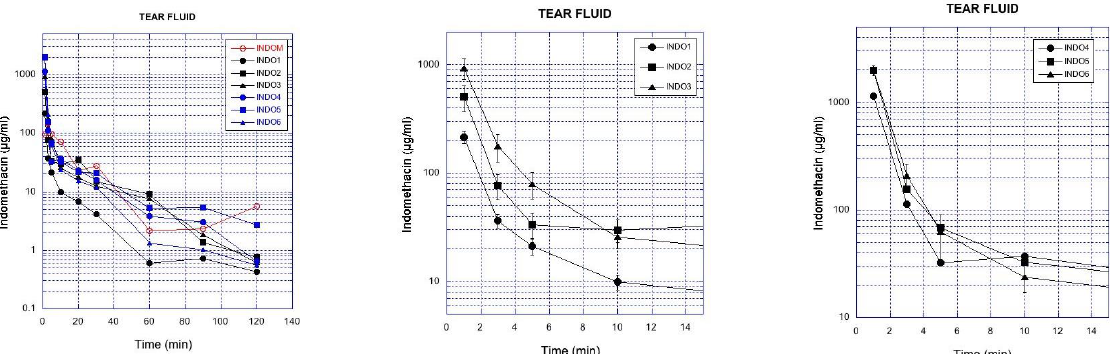
Figure 2. Left . Mean concentration of indomethacin in the rabbit tear fluid after instillation of the suspensions (Indom ® , INDO1-INDO6). Middle . Indomethacin concentrations (mean ± SEM) in the tear fluid after instillation of the small particles as low (INDO1), medium (INDO2), and high viscosity (INDO3) suspensions. Right . Indomethacin concentrations (mean ± SEM) in the tear fluid after instillation of the large particles as low (INDO4), medium (INDO5), and high viscosity (INDO6) suspensions.